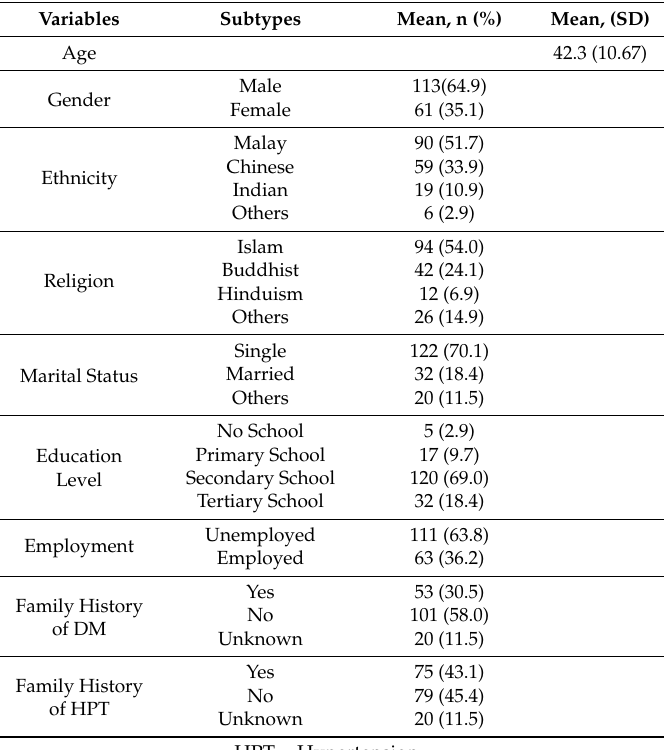
Table 1. Sociodemographic characteristics of the study